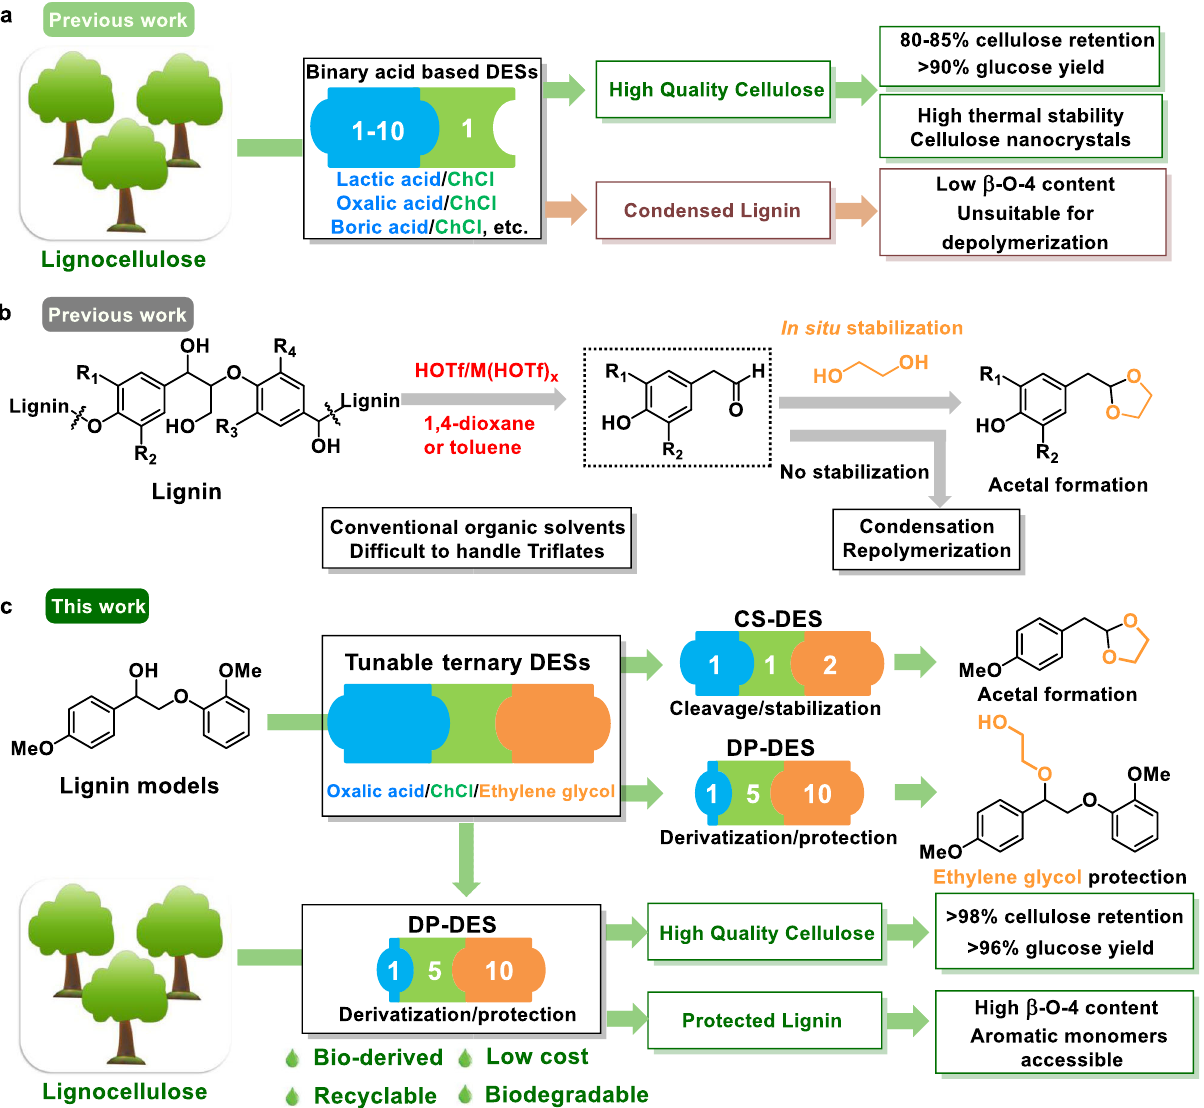
Fig. 1 Development of tunable and functional DESs for lignocellulose valorization. a Binary acid-based deep eutectic solvents (ChCl as HBA and oxalic acid or lactic acid as HBDs) for lignocellulose fractionation resulting in good quality cellulose (80 – 85% cellulose retention), which can be digested to >90% glucose or nanocellulose and condensed lignin fragments with low β -O-4 16,18 . b Capturing reactive intermediates in the acid-catalyzed scission of β -O-4 linkages during lignin depolymerization in order to prevent recondensation phenomena. Instable C2-aldehydes are trapped in the form of their cyclic C2- acetals using diols. Reactions were carried out in conventional organic solvents using strong acids. c This work: Tunable ternary DES systems (choline chloride, ChCl as HBA and oxalic acid, OA and ethylene glycol, EG as HBDs) for controlled lignin depolymerization and lignocellulose fractionation as environmentally benign alternatives for conventional organic solvents. Control over the product outcome (cleavage/stabilization versus derivatization/ protection) in acidolysis of lignin model compounds by adjusting the relative ratios of HBA and HBD. Ef fi cient lignocellulose fractionation with integrated DES recycling and isolation of high-quality cellulose (>98% cellulose retention), which can be digested to >96% glucose as well as protected, high β -O-4 content lignin highly suited for depolymerization to aromatic